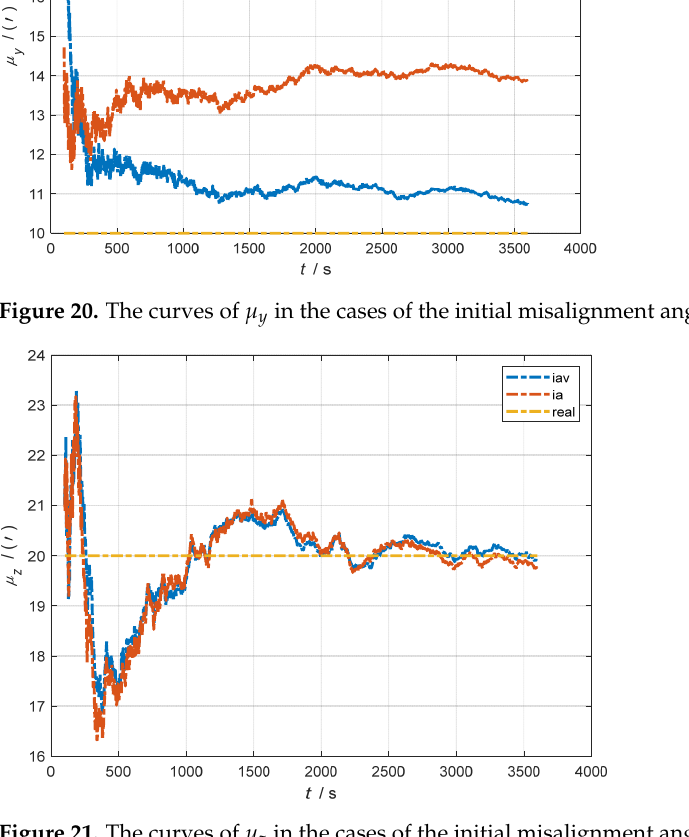
Figure 21. The curves of µ z in the cases of the initial misalignment angles [ 5 ◦ 5 ◦ 20 ◦ ] T .